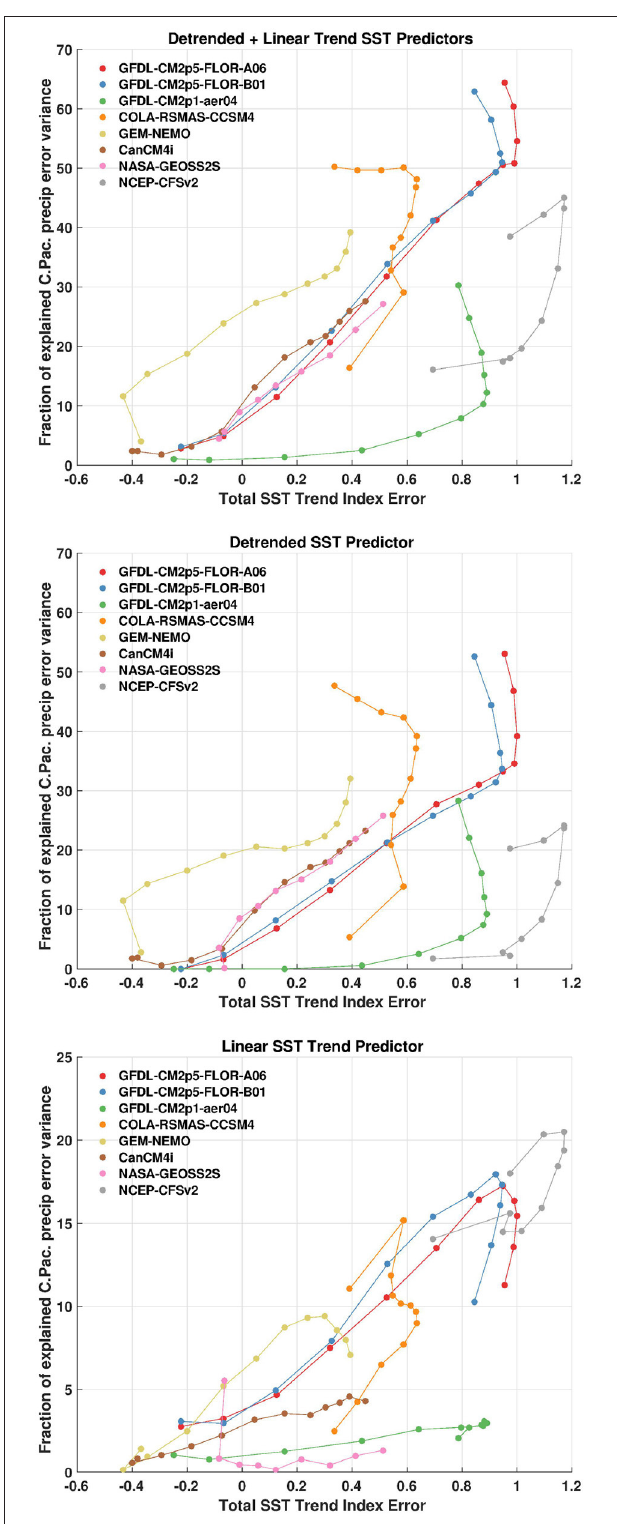
FIGURE 8 | (Top) Correlation between the 2-predictor regression and the error in the central Pacific precipitation anomaly index. The predictors are the